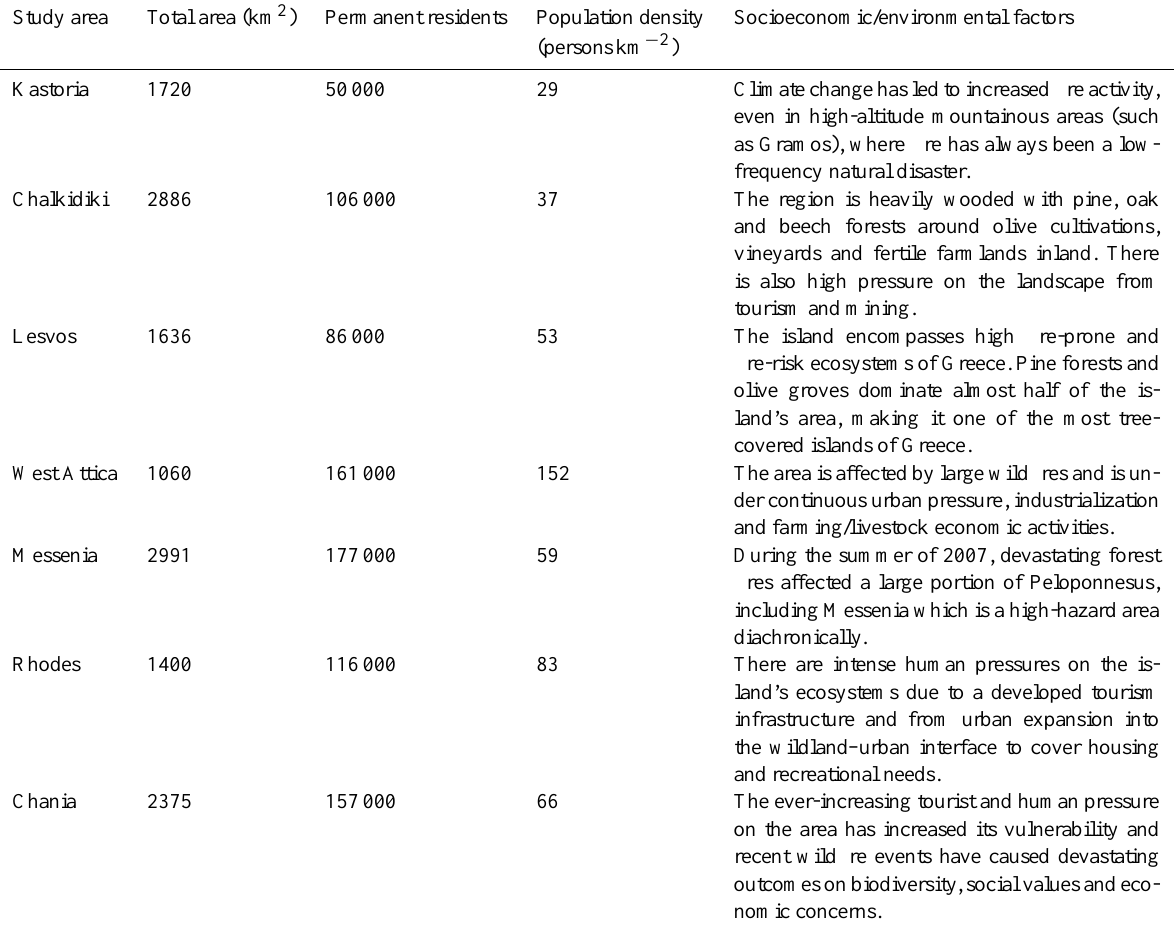
Table 1. Description of study areas used to test implementation of the AEGIS platform. Study